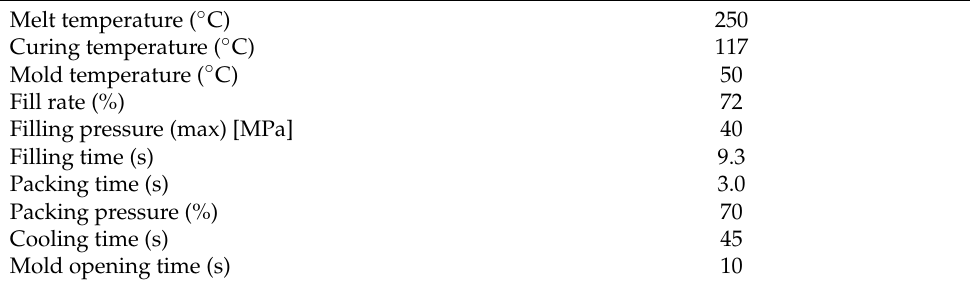
Table 2. Injection molding parameters of recycled polypropylene